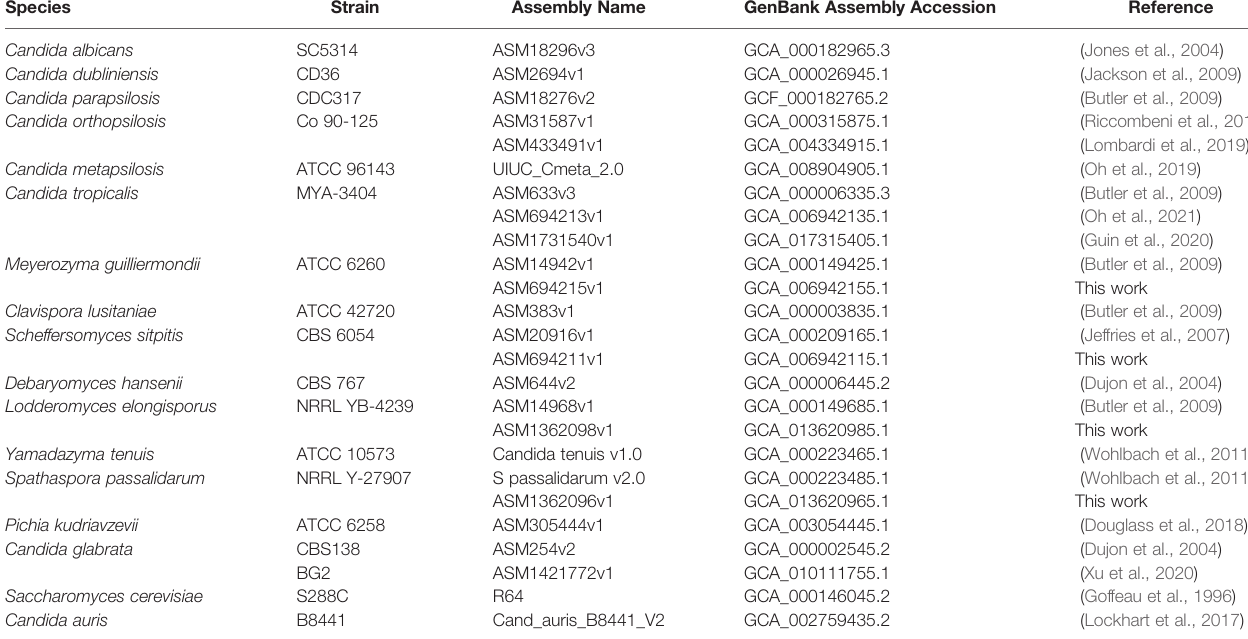
TABLE 1 | Principal genome sequences used for ALS gene